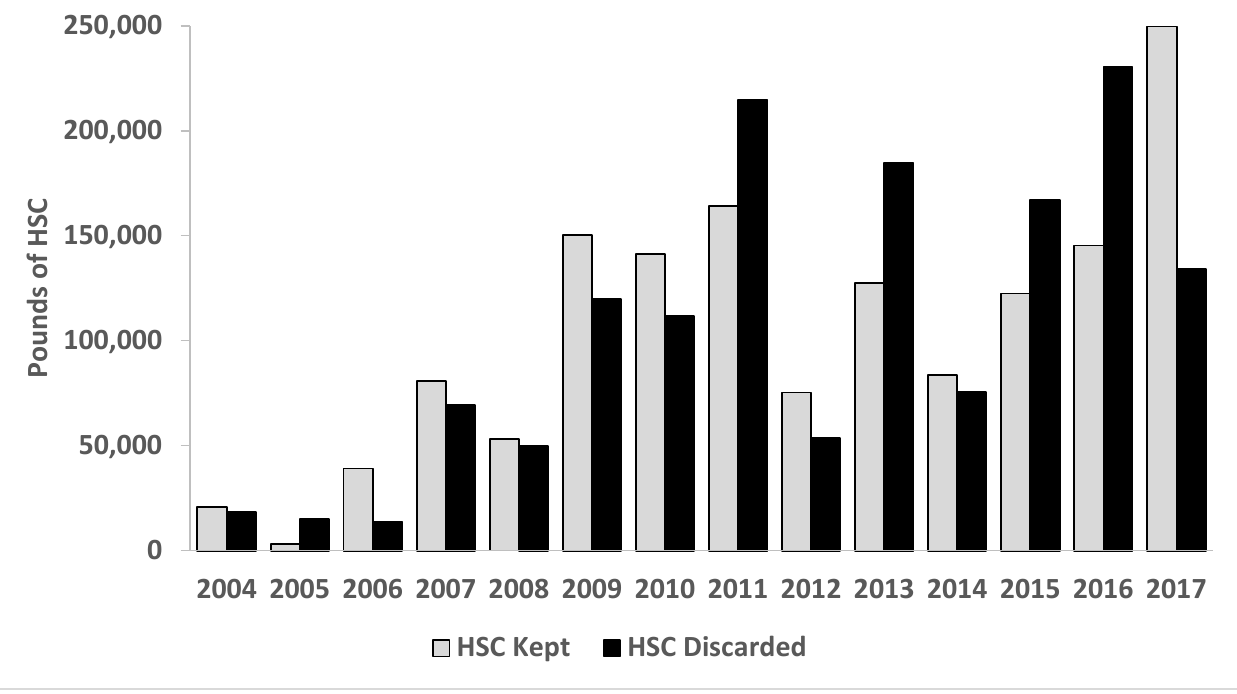
Figure 13. Total pounds of horseshoe crabs (HSC) discarded and horseshoe crabs kept in observed fishing trips in the NEFOP data set for the Delaware Bay states, 2004-2017.